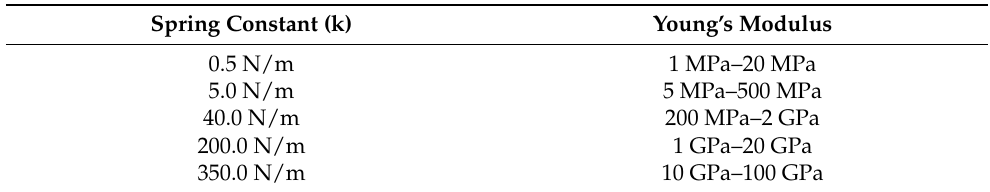
Table 2. The most convenient AFM cantilever spring constants related to the expected Young’s modulus of soft matter